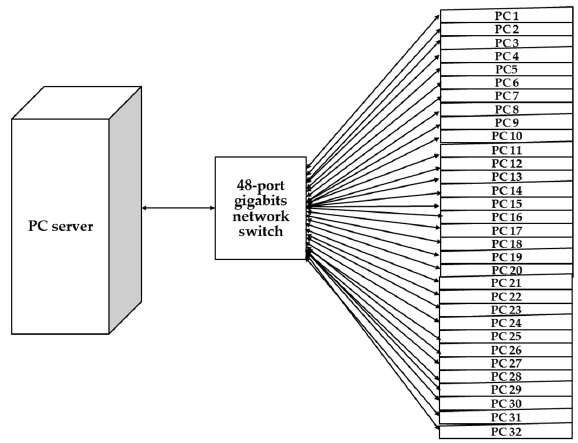
Figure 6. The experiments of massive deployment in large-scale computers. 32 PC clients were connected to the PC server with 48-port Cisco network switch and the Category 5e network cables.